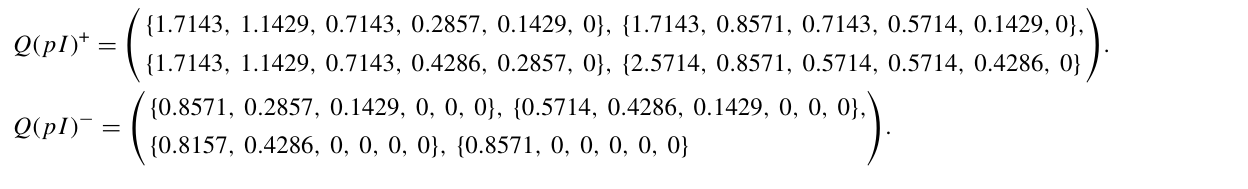
Fig. 3 Importance degree of each attribute in the two